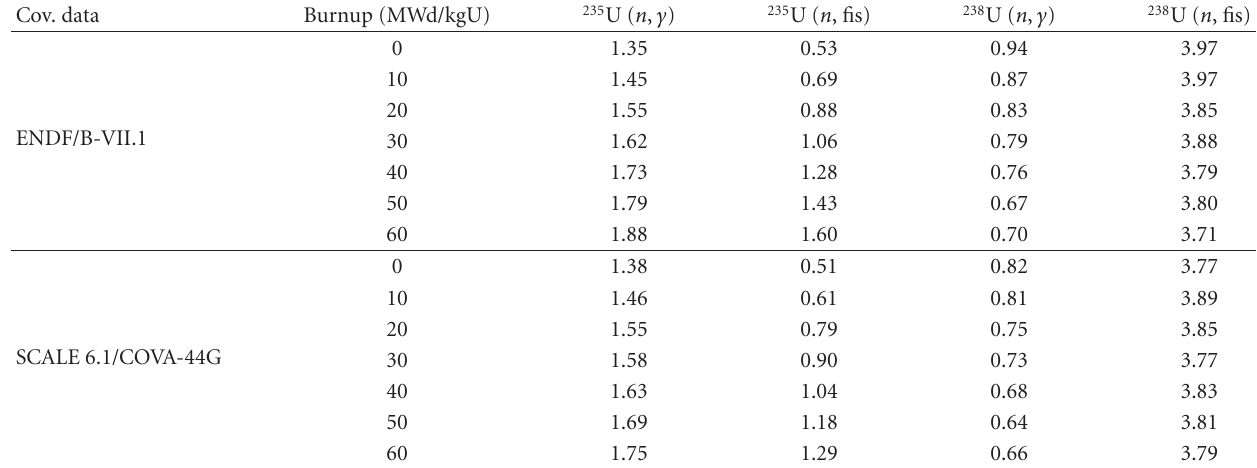
Table 3: RSDs (%) of one-group reaction rates with ENDF/B-VII.1 and SCALE6.1/COVA covariance data . Cov. data